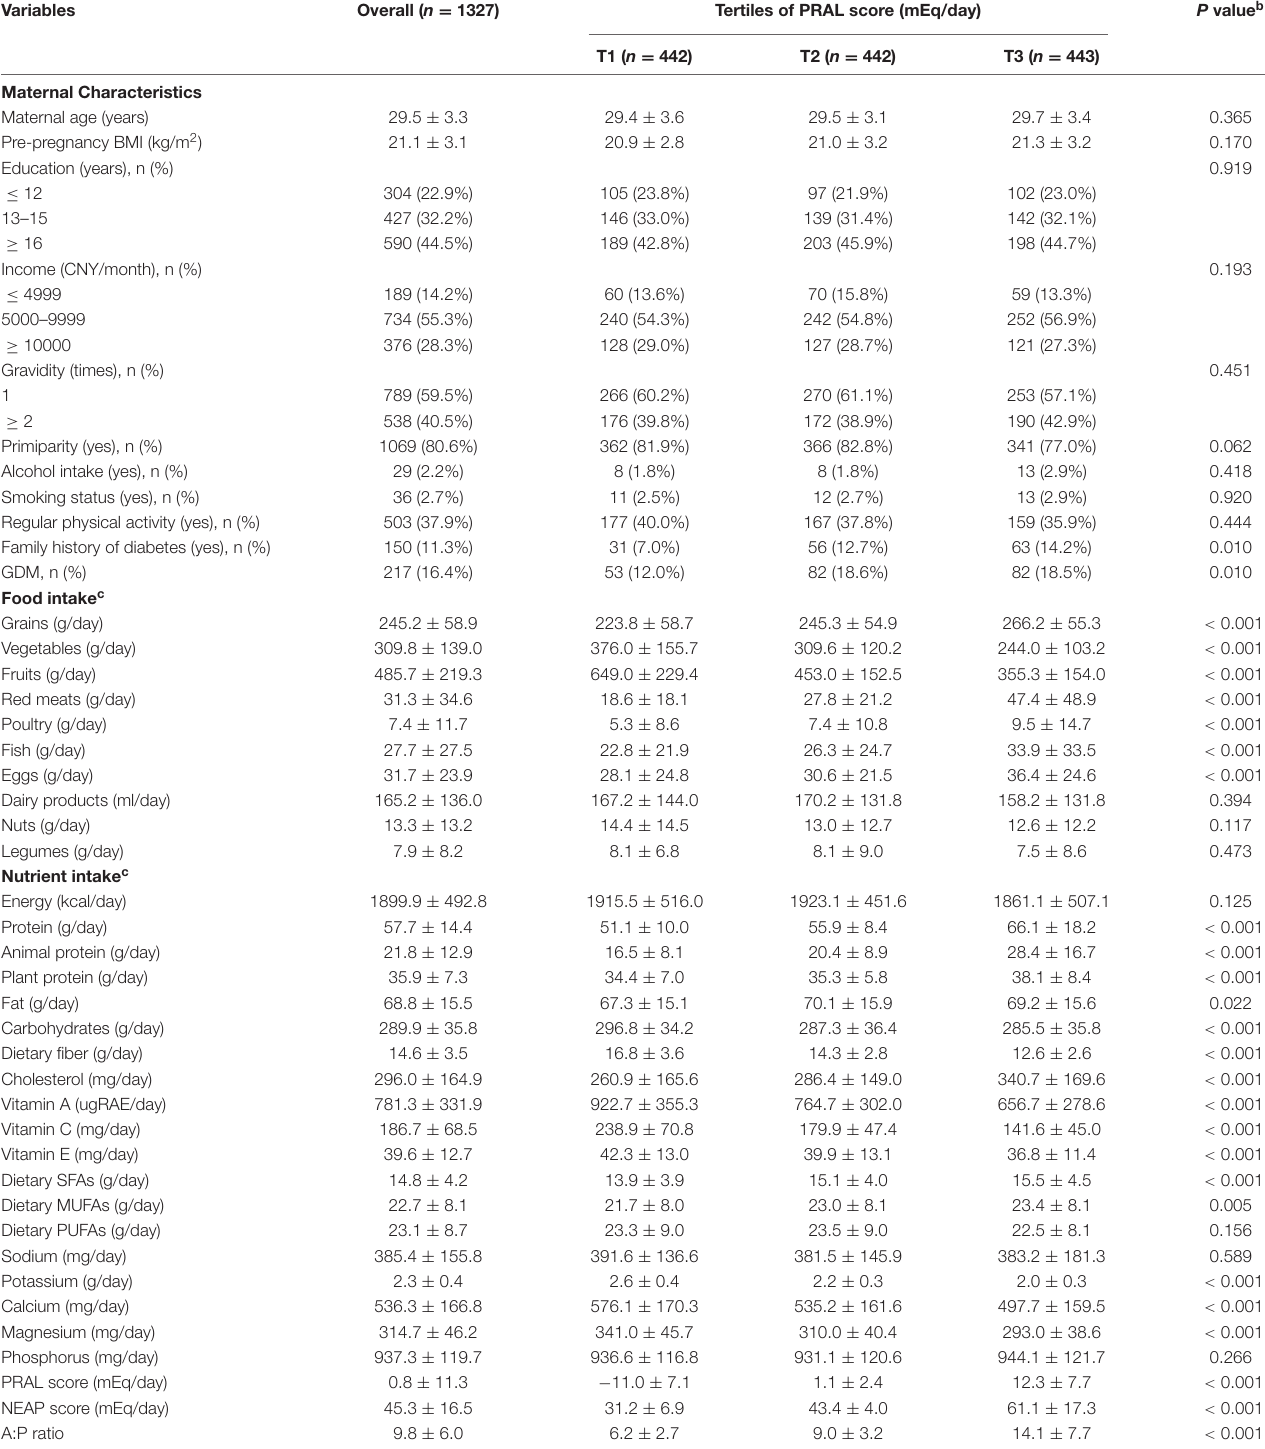
TABLE 1 | Characteristics of study participants according to tertiles of the PRAL score a . Variables Overall ( n = 1327) Tertiles of PRAL score